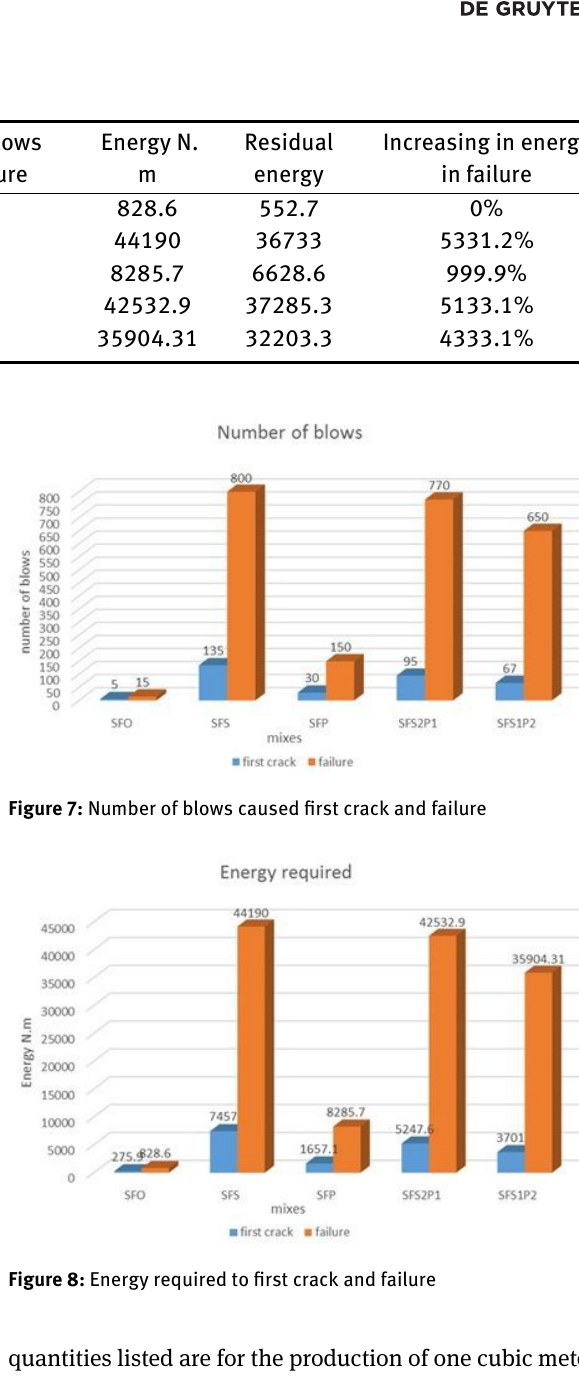
quantities listed are for the production of one cubic meter of SIFCON.